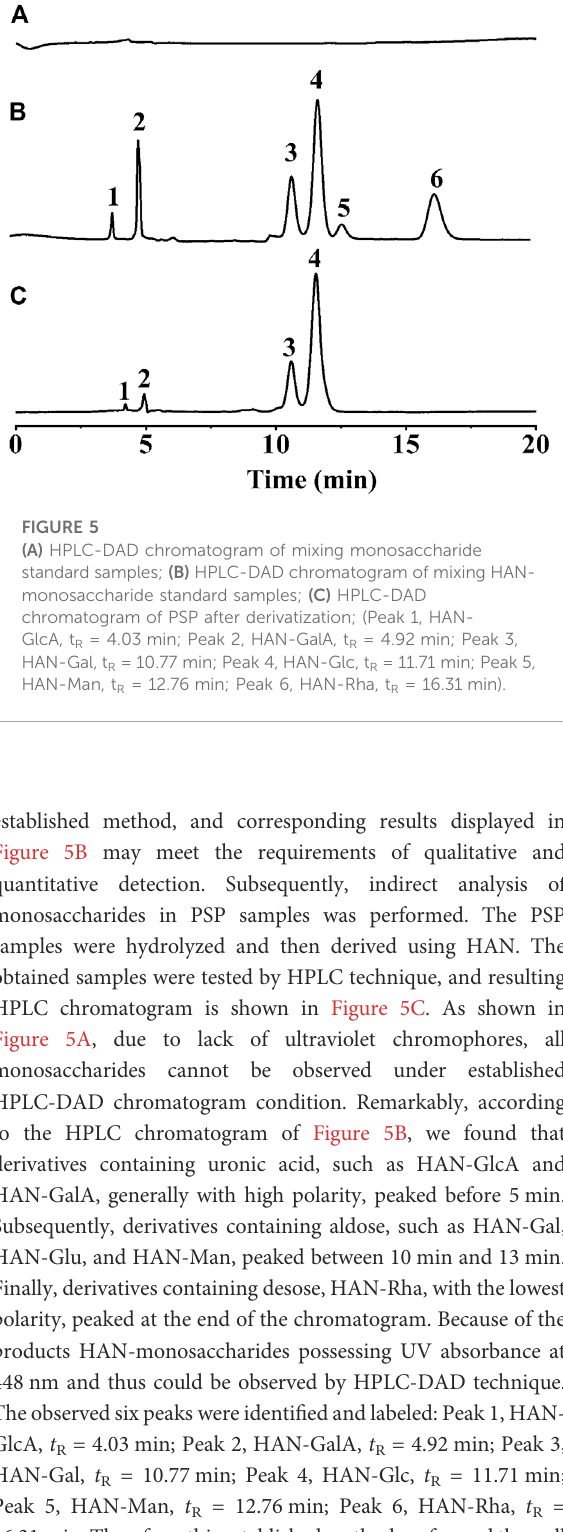
TABLE 3 Determination of monosaccharide composition of